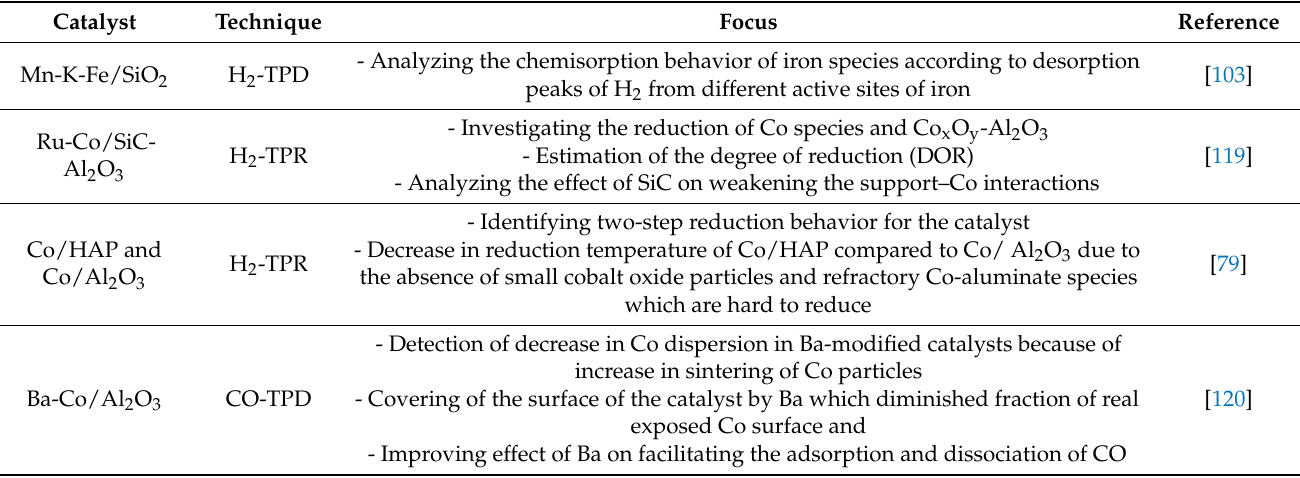
Table 8. Characterization techniques based on thermal methods for Fe and Co catalyst in FTS.